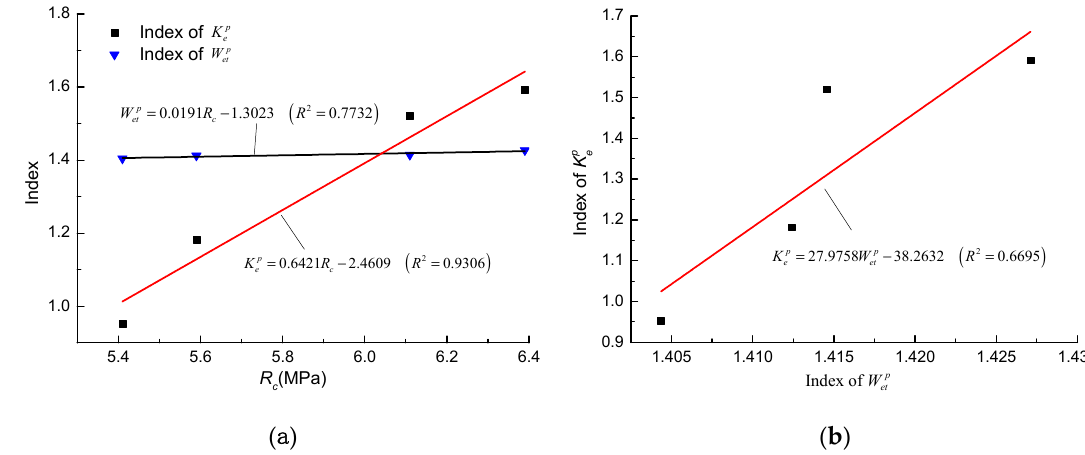
K and p W . e et K and p W . et e et